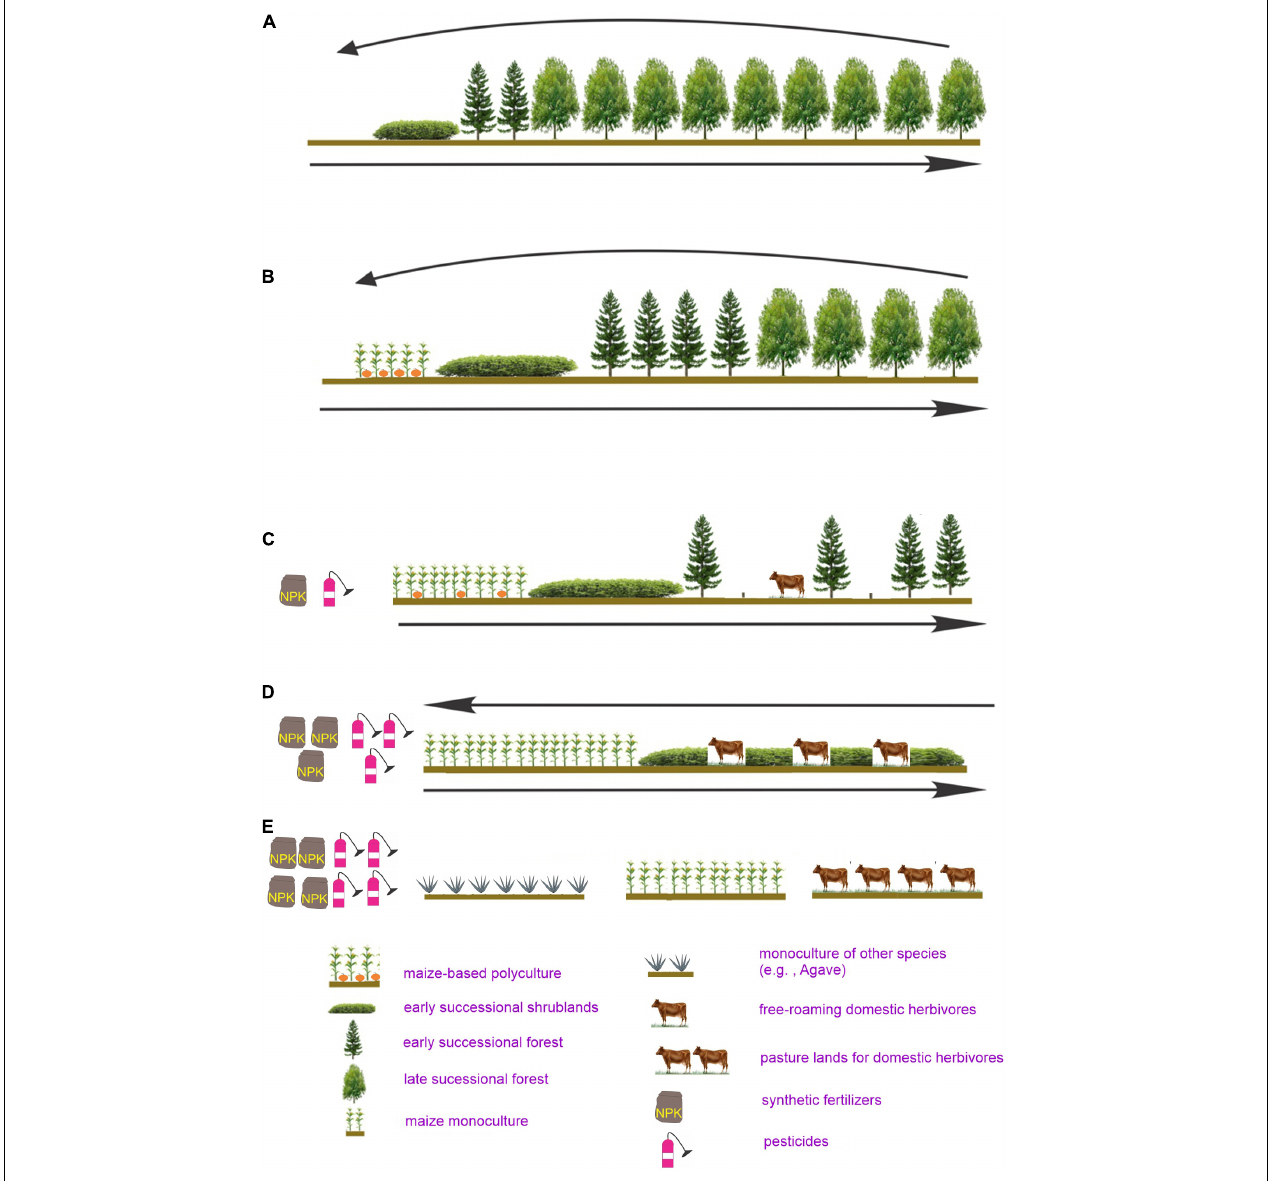
FIGURE 6 | Successional changes expected in the SMP mountains. (A) Before human occupation. (B) After the human occupation before the Spanish conquest, and in contemporary-traditional milpas. In the Spanish aftermath, the simplification of the successional process became increasingly common and exacerbated by human population growth, resulting in (C) the elimination or reduction of old-growth forests and the dominance of fallows composed of early successional forests and successional shrublands ( acahuales ), (D) the elimination or reduction of pioneer forests and the prevalence of acahuales as the main fallow land. Finally (E) , the elimination of acahaules and their replacement be maize fields and other agricultural lands, accompanied by the increasing use of